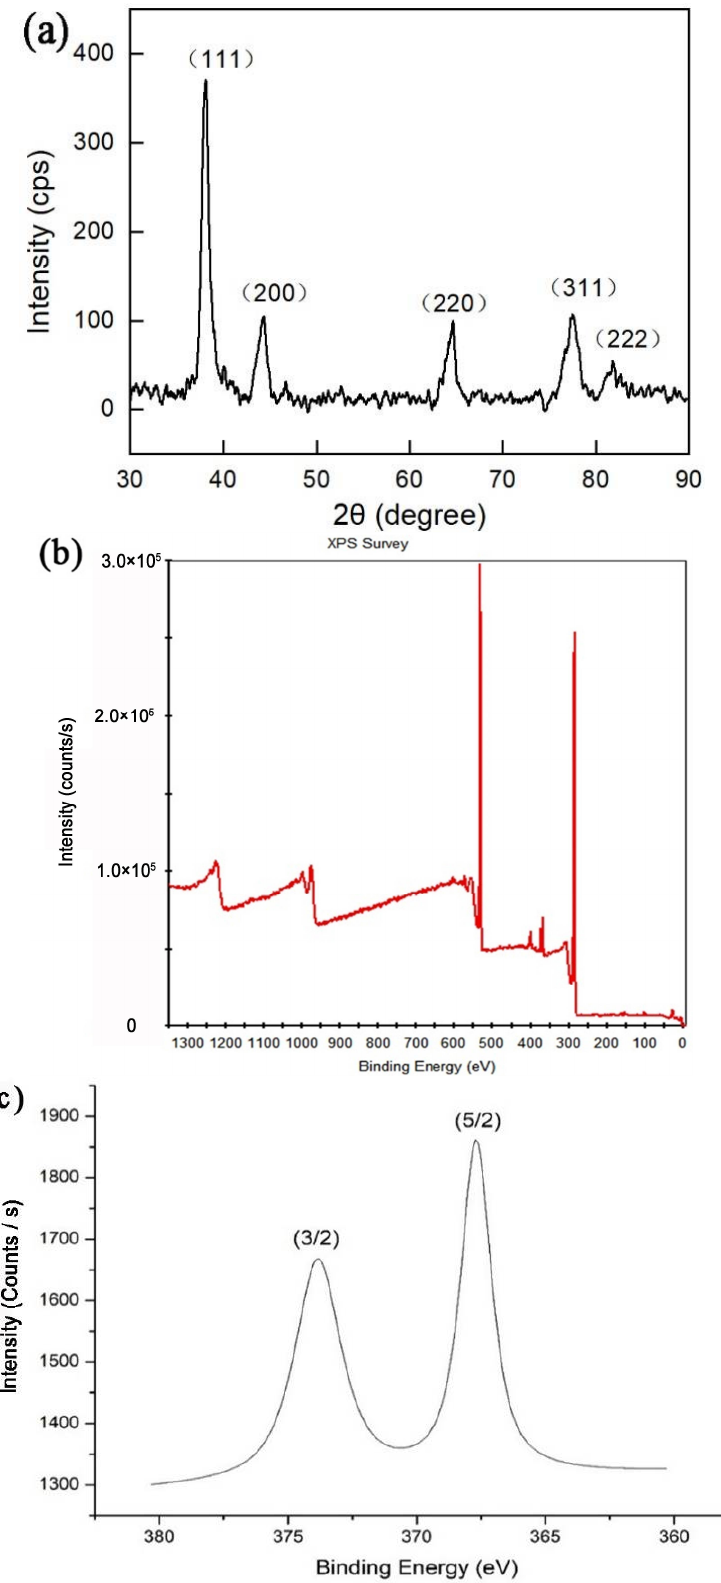
Figure 4. ( a ) XRD spectrum of the functionalized chestnut-shell-extract Ag nanoparticles. ( b ) XPS pattern of the functionalized chestnut-shell-extract AgNPs. ( c ) XPS pattern of Ag element in the functionalized chestnut-shell-extract AgNPs.